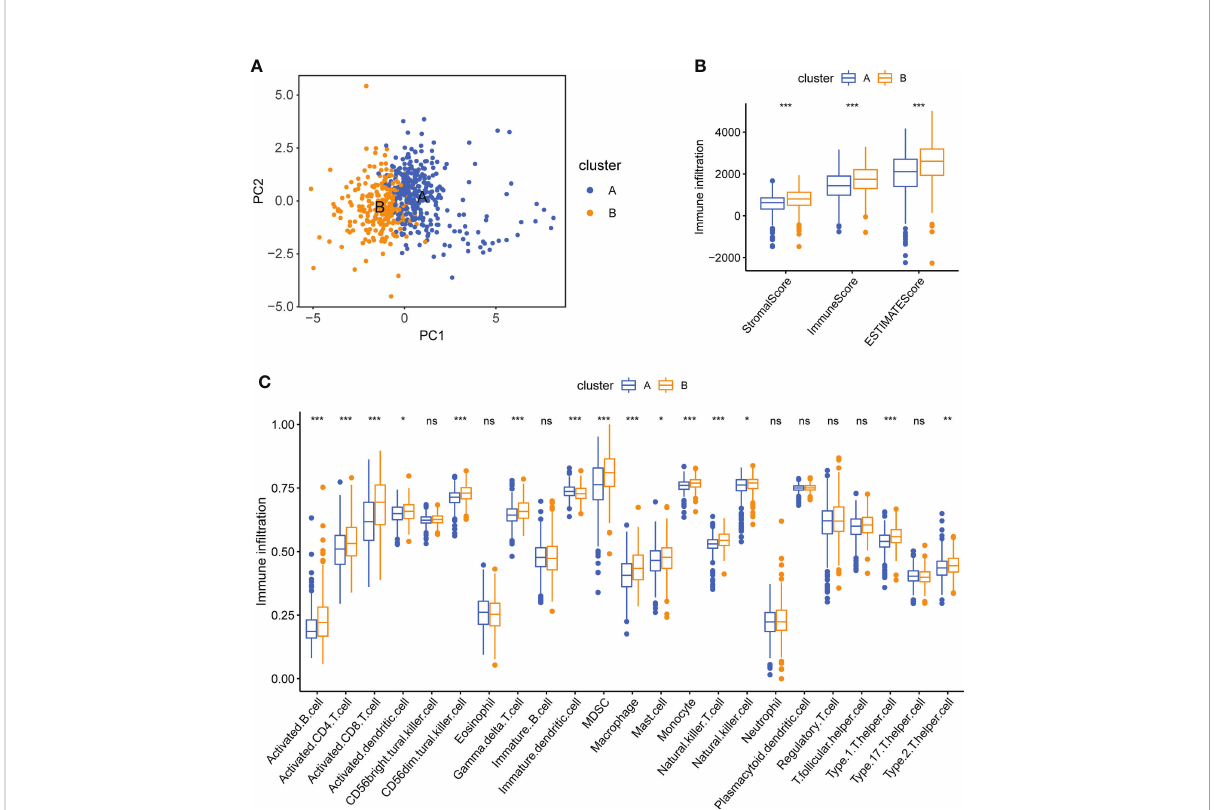
FIGURE 4 Tumor immune microenvironment analysis of two CPG subtypes. (A) PCA shows a signi fi cant difference in transcriptomes between the two subtypes. (B) Correlations between the two CPG subtypes and TME score. (C) The abundance of 23 kinds of in fi ltrating immune cells was evaluated by ssGSEA in the two CPG subtypes. CPG, cuproptosis-promoting gene; ns, no signi fi cant difference, *p < 0.05; **p < 0.01; and ***p <